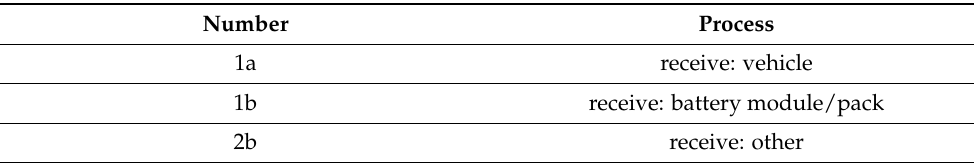
Table A1. Activities of the main process “preparation”: receiving.